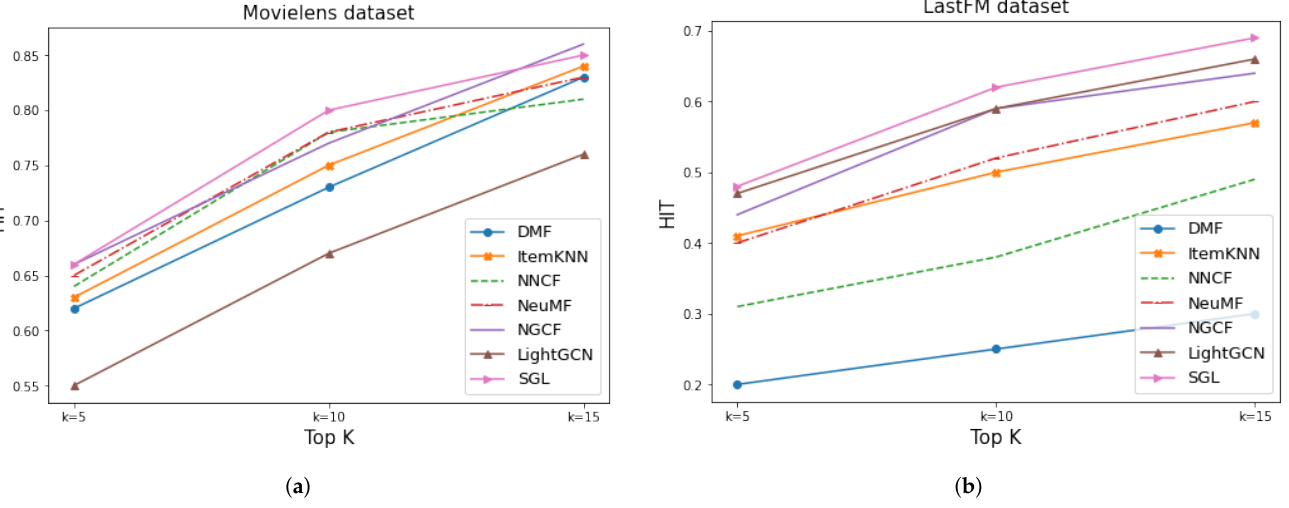
Figure 14. Results of HIT for Movielens and LastFM. ( a ) MovieLens HIT. ( b ) LastFM HIT.